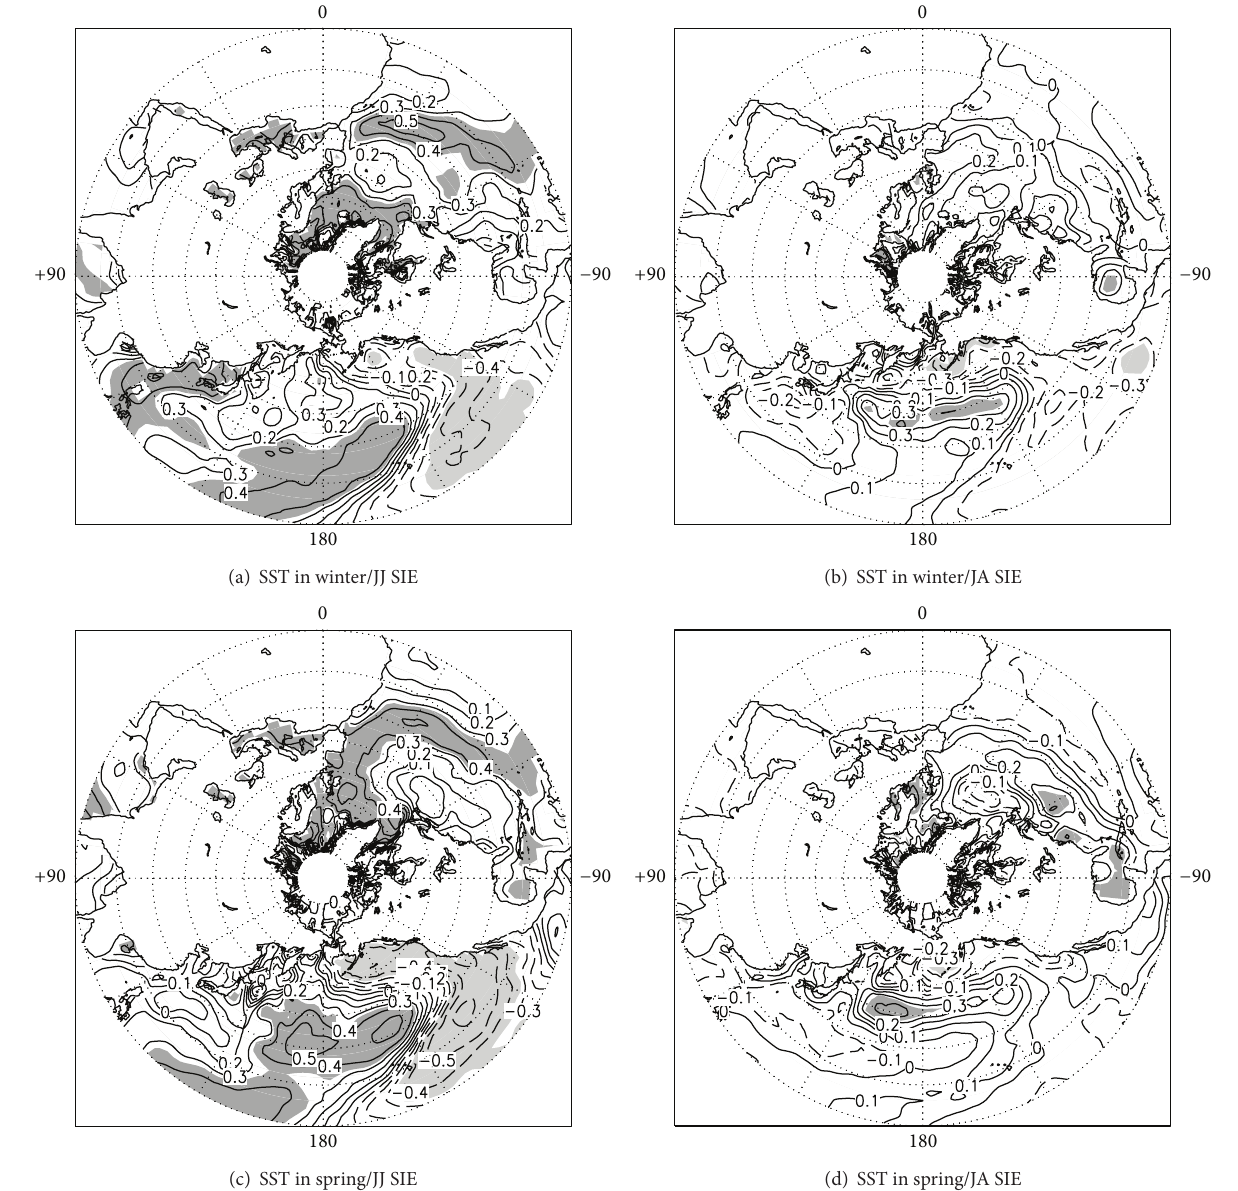
Figure 10: The correlation distributions between sea surface temperature (SST) in preceding winter (DJF) and spring (MAM) with SIE difference for JJ and JA over the north of 10 ∘ N: (a) SST in winter and JJ SIE, (b) SST in winter and JA SIE, (c) SST in spring and JJ SIE, and (d) SST in spring and JA